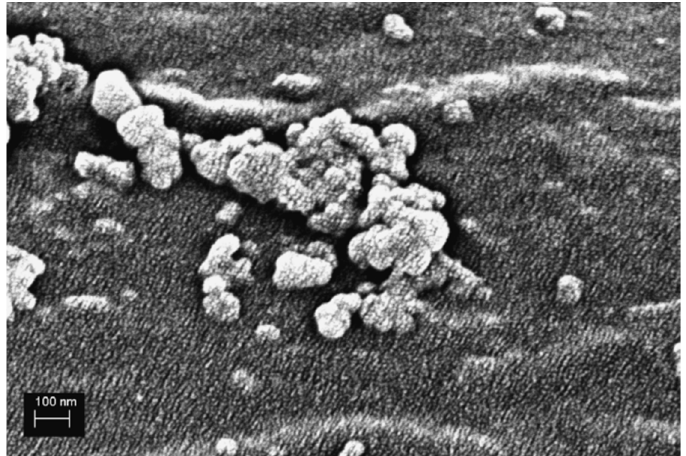
Figure 2. SEM EsB image of the microwave treated fiber surface highlighting the Z-contrast between the fiber surface and